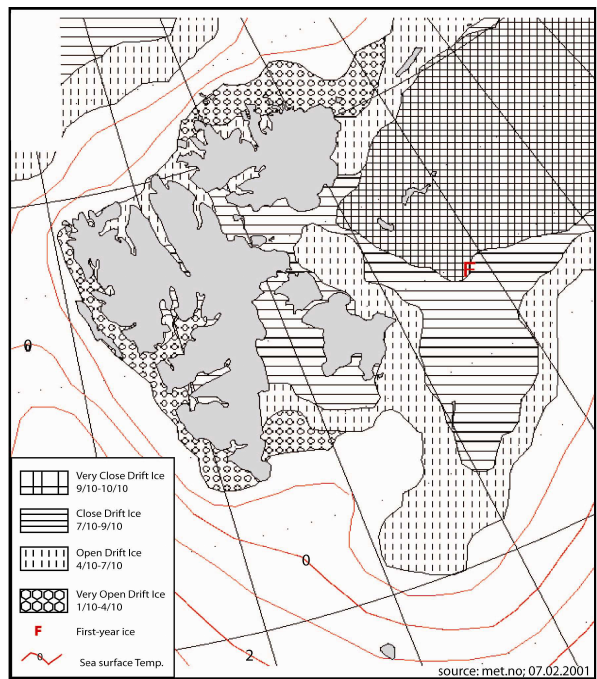
Fig. 2. Sea ice conditions around Spitsbergen on 7 February 2001, the year when the offshore drill core samples were taken (source: www.met.no).